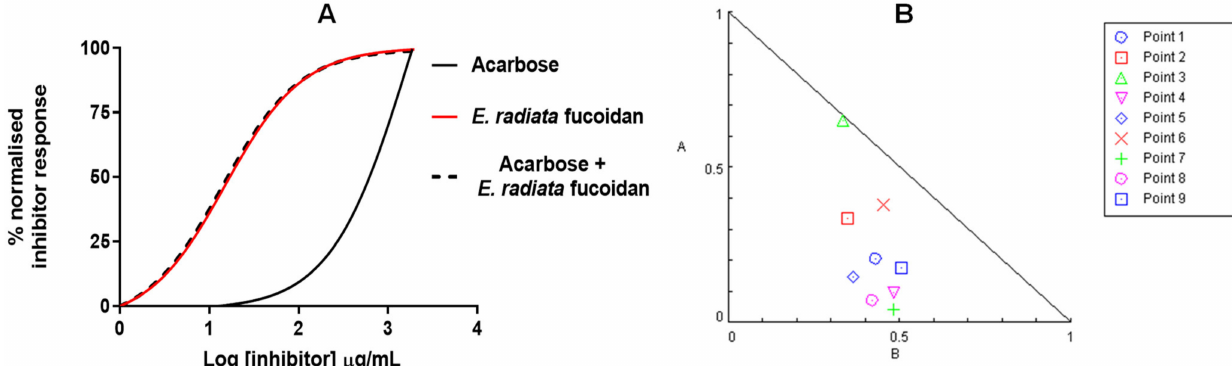
Figure 7. E. radiata fucoidan synergistically inhibits the activity of α -glucosidase. ( A ) Dose-response curves of the inhibition potential of compounds on α -glucosidase. ( B )Normalised isobologram analysis of acarbose and E. radiata fucoidan combinations. The axes scales (A-acarbose & B- E.radiata ) represents the affected fraction (inhibited enzyme). Various combinations of acarbose and E. radiata fucoidan based on IC 75 , IC 50 and IC 25 values were tested by the Compusyn software and the combination indexes determined. The points below the hypotenuse line of the triangles indicate synergy at a particular effect.